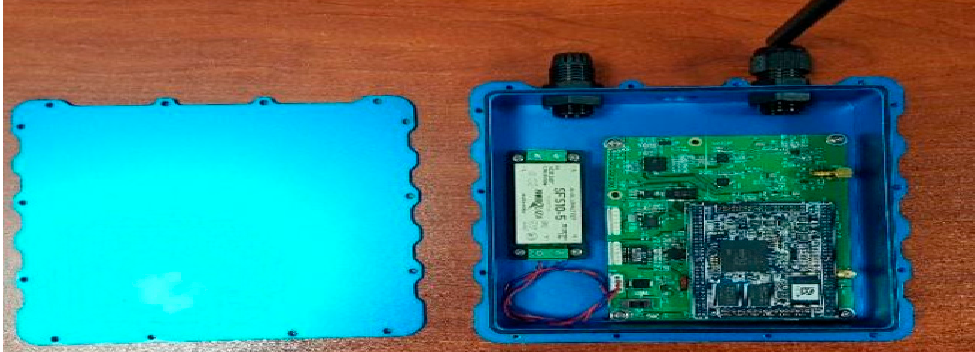
Figure 10. The communication node of sap collection tank.